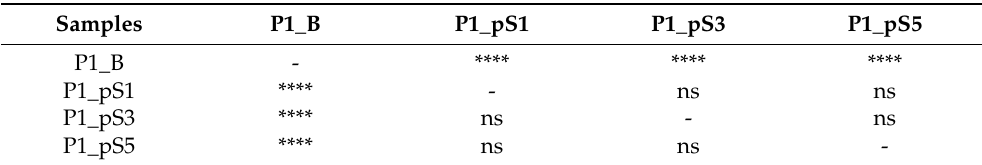
Figure 9. Relative ALP expression of Saos-2 cells on scaffolds: without pSPIONs (P1_B), containing 1.92 wt.% of pSPIONs (P1_pS1), containing 3.77 wt.% of pSPIONs (P1_pS3), and containing 5.54 wt.% of pSPIONs (P1_pS5). Table 7. Results of the statistical significance tests regarding the differences between the relative ALP expressed by Saos-2 cells on scaffolds: P1_B, P1_pS1, P1_pS3, and P1_pS5. Statistical analysis was performed by comparing the relative ALP expression of the Saos-2 cells for the whole duration of the cell